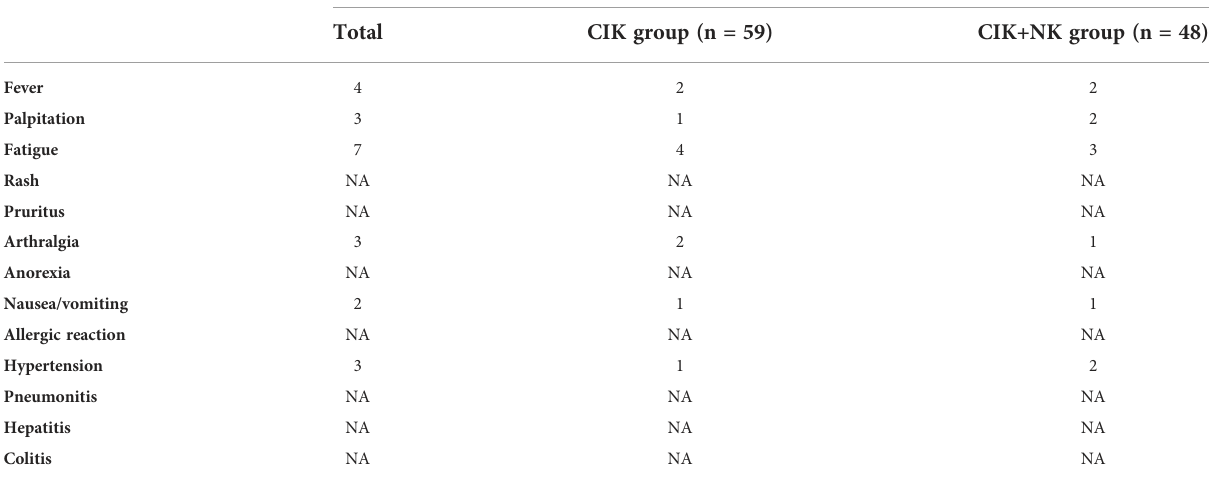
CIK, cytokine-induced killer; NK, natural killer; NA, not